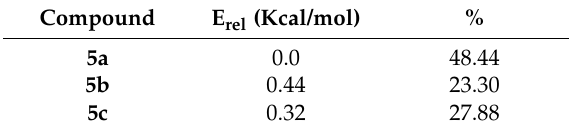
Figure 10. Rotamers for 5 . Table 7. Boltzmann population for rotamers of 5 .